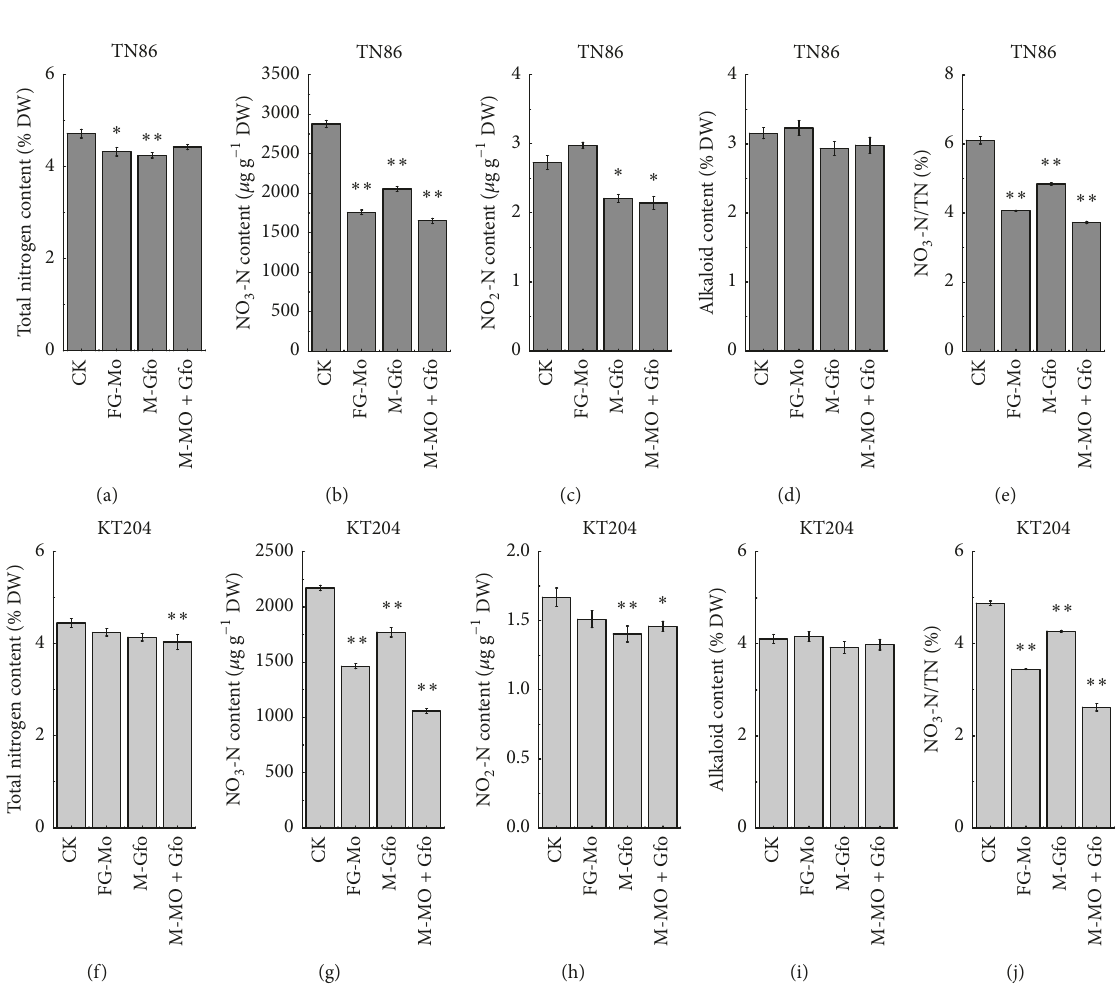
Figure 4: Effects of treatments on total nitrogen content, NO 3 -N content, NO 2 -N content, alkaloid content, and NO 3 -N/TN in burley tobacco. NO 3 -N/TN: ratio of NO 3 -N and total nitrogen content (TN). Error bars represent standard error ( 𝑛 = 3 ). Symbols ∗∗ and ∗ indicate significant difference at 0.01 or 0.05,